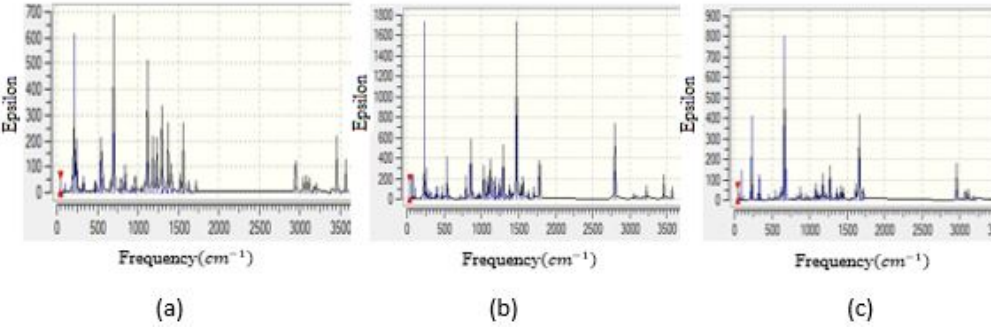
Figure 3: Infrared spectra each of the dopamine (a), L-DOPA (b), and quinone (c).